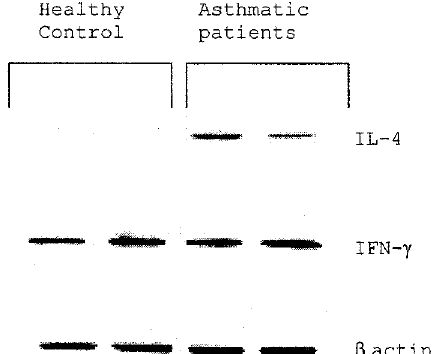
FIG. 1. Expression of mRNA for IL–4 and IFN– g in sputum mononuclear cells from asthmatic patients and healthy controls. The cytokine polymerase chain reaction (PCR) product were dot-blotted, hybridized with a specific probe, and the results were shown comparatively to those of b -actin